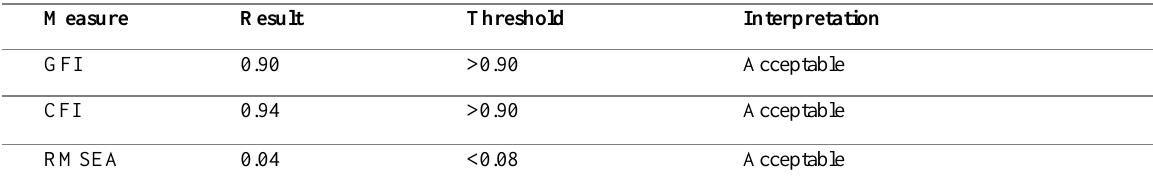
Table 3: Model fits for intellectual